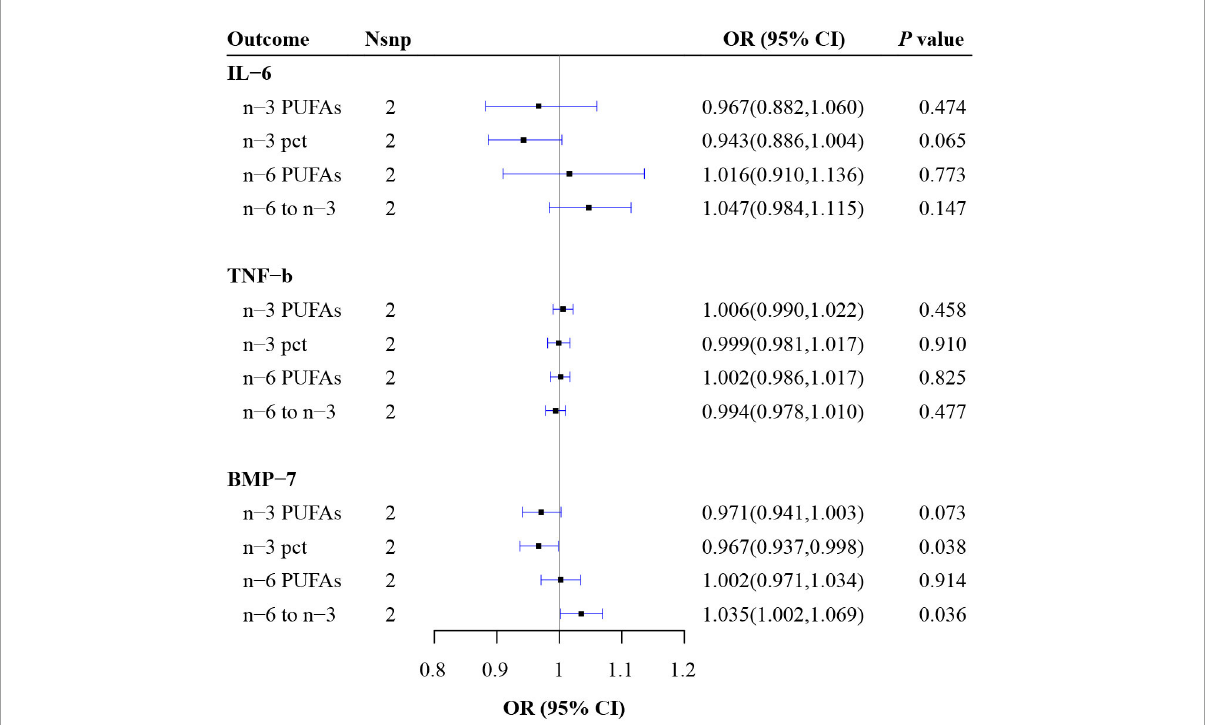
FIGURE2 Mendelian randomization (MR) estimate results of possible confounding factors on polyunsaturated fatty acids (PUFAs). n-3 pct, the ratio of n-3 fatty acids to total fatty acids; n-6 to n-3, the ratio of n-6 PUFAs to n-3 PUFAs; IL, interleukin; TNF, tumor necrosis factor; BMP, bone morphogenetic